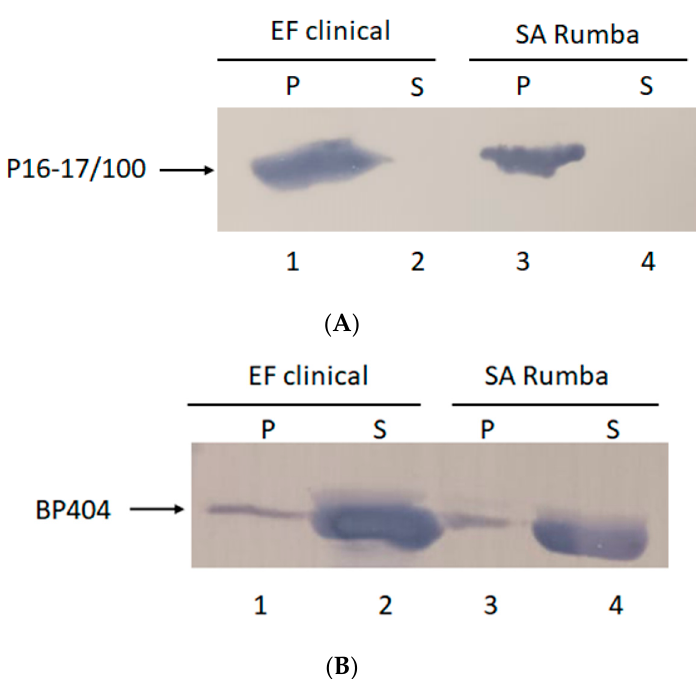
Figure 3. Cell-wall binding assay to determine the binding of protein P16-17/100 and BP404 towards clinical E. faecalis clinical isolate and S. aureus Rumba. ( A ) P16-17/100 protein was able to bind to the cells of E. faecalis (lane 1) and S. aureus Rumba (lane 3). No unbound protein was found in the supernatant fraction (lane 2 and lane 4). ( B ) Partial binding of BP404 was found towards E. faecalis clinical (lane 1) and S. aureus Rumba (lane 3). Most of the protein was found in the unbound supernatant fraction (lane 2 and lane 4).